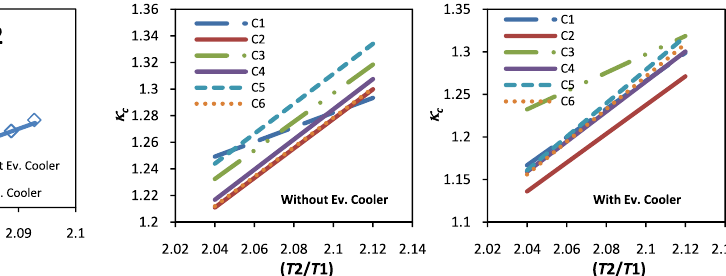
Fig. 5. Variations of k c against temperature ratio.